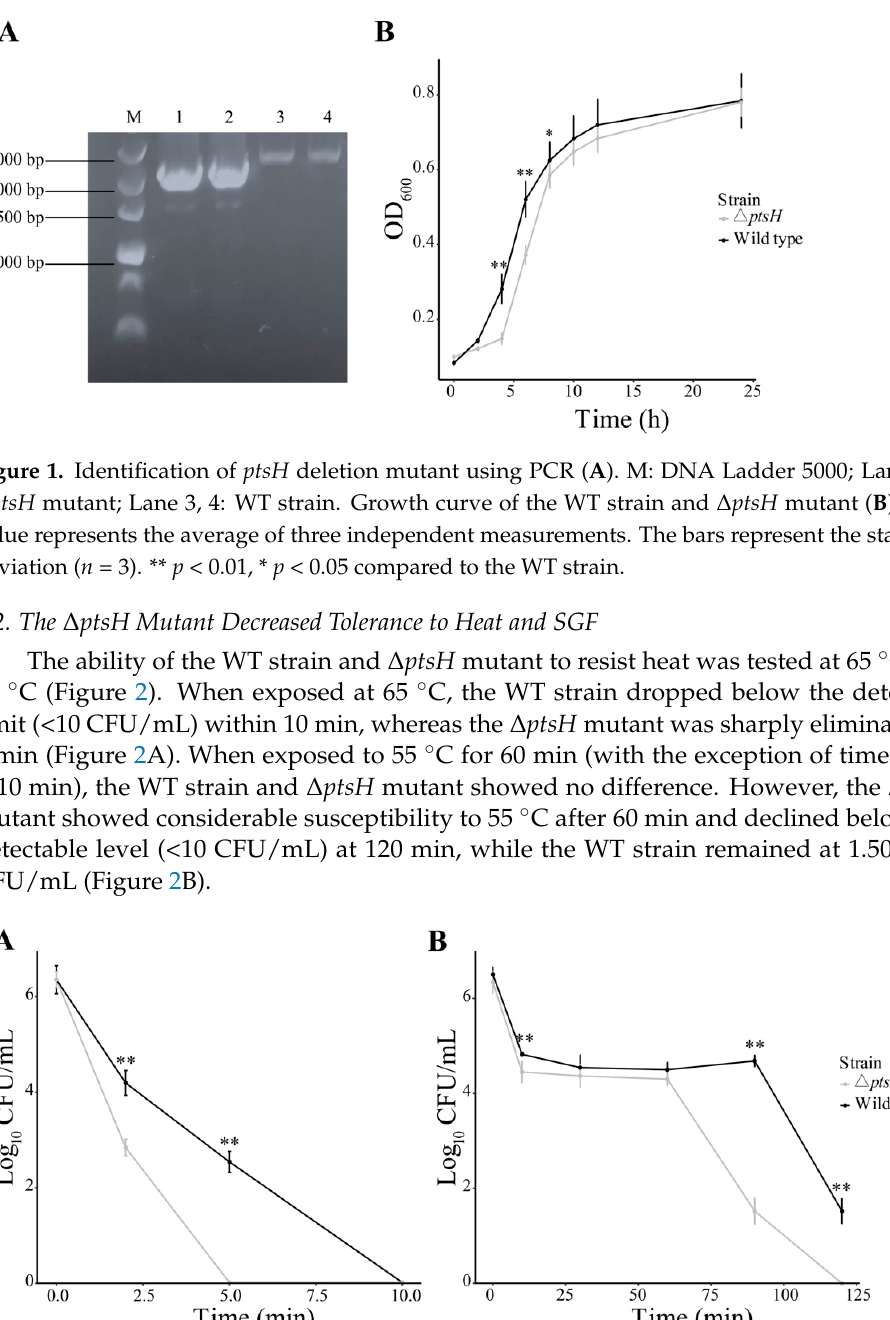
Figure 3. SGF tolerance of the WT strain and the Δ ptsH mutant. ** p < 0.01 compared to the WT strain. 3.3. The Δ ptsH Mutant Enhanced Tolerance to Osmotic Stress The viability of the Δ ptsH mutant under high osmotic stress was investigated by dif- ferent concentrations of NaCl. The WT strain has higher sensitivity to 10%, 15%, and 20% NaCl compared with the Δ ptsH mutant during the 120 min (Figure 4A–C). The adaption of the Δ ptsH mutant was enhanced by the rising osmotic pressure. The populations of the ptsH mutant were, respectively, 0.63, 1.04, and 1.46 log 10 CFU/mL greater than those of the WT strain as the concentration of NaCl increased (at the 60 min time point).